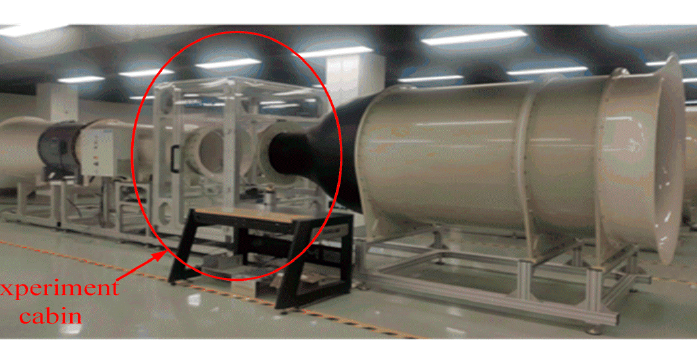
Figure 3. Straight open wind tunnel.